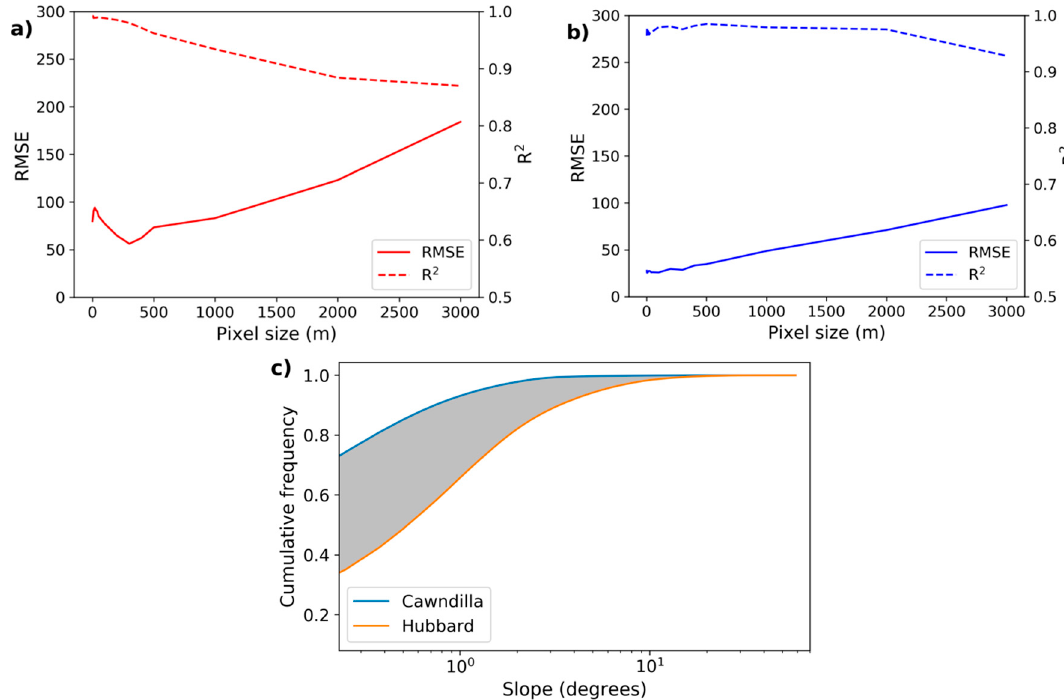
Figure 13. Effect of pixel size on the volume estimation errors for the Cawndilla ( a ) and the Hubbard ( b ) reservoirs. The slope differences between reservoirs are also presented ( c ).